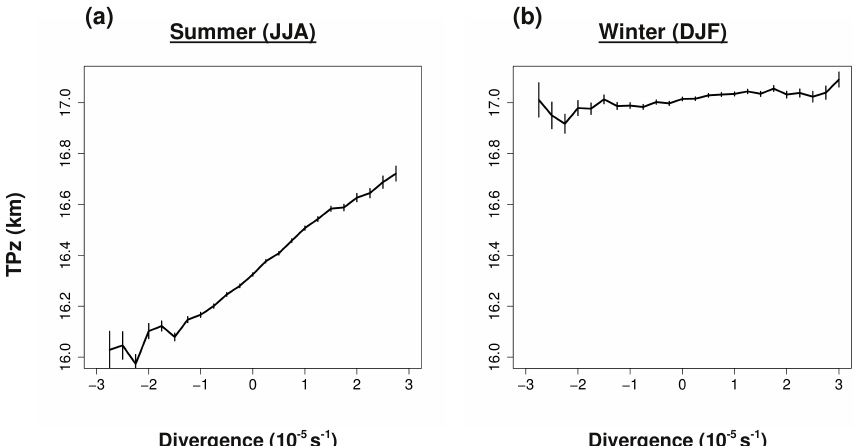
Figure A1. Diagrams of divergence vs. tropopause height (TP z , kilometers) for the latitude band 10 ◦ S–10 ◦ N. Panel (a) belongs to the summer season (JJA) and (b) to the winter season (DJF). Vertical bars denote 1 standard deviation of the mean value.